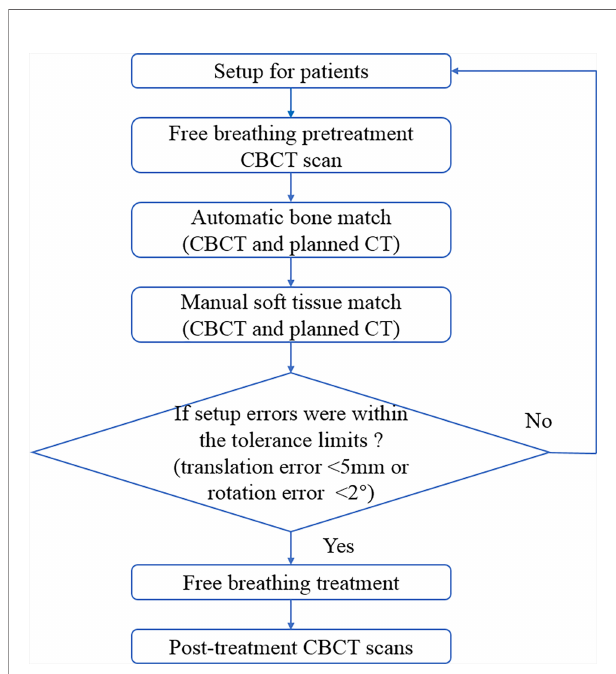
FIGURE 2 | Patients treatment work fl ow for each treatment fraction. CBCT, cone-beam computed tomography.